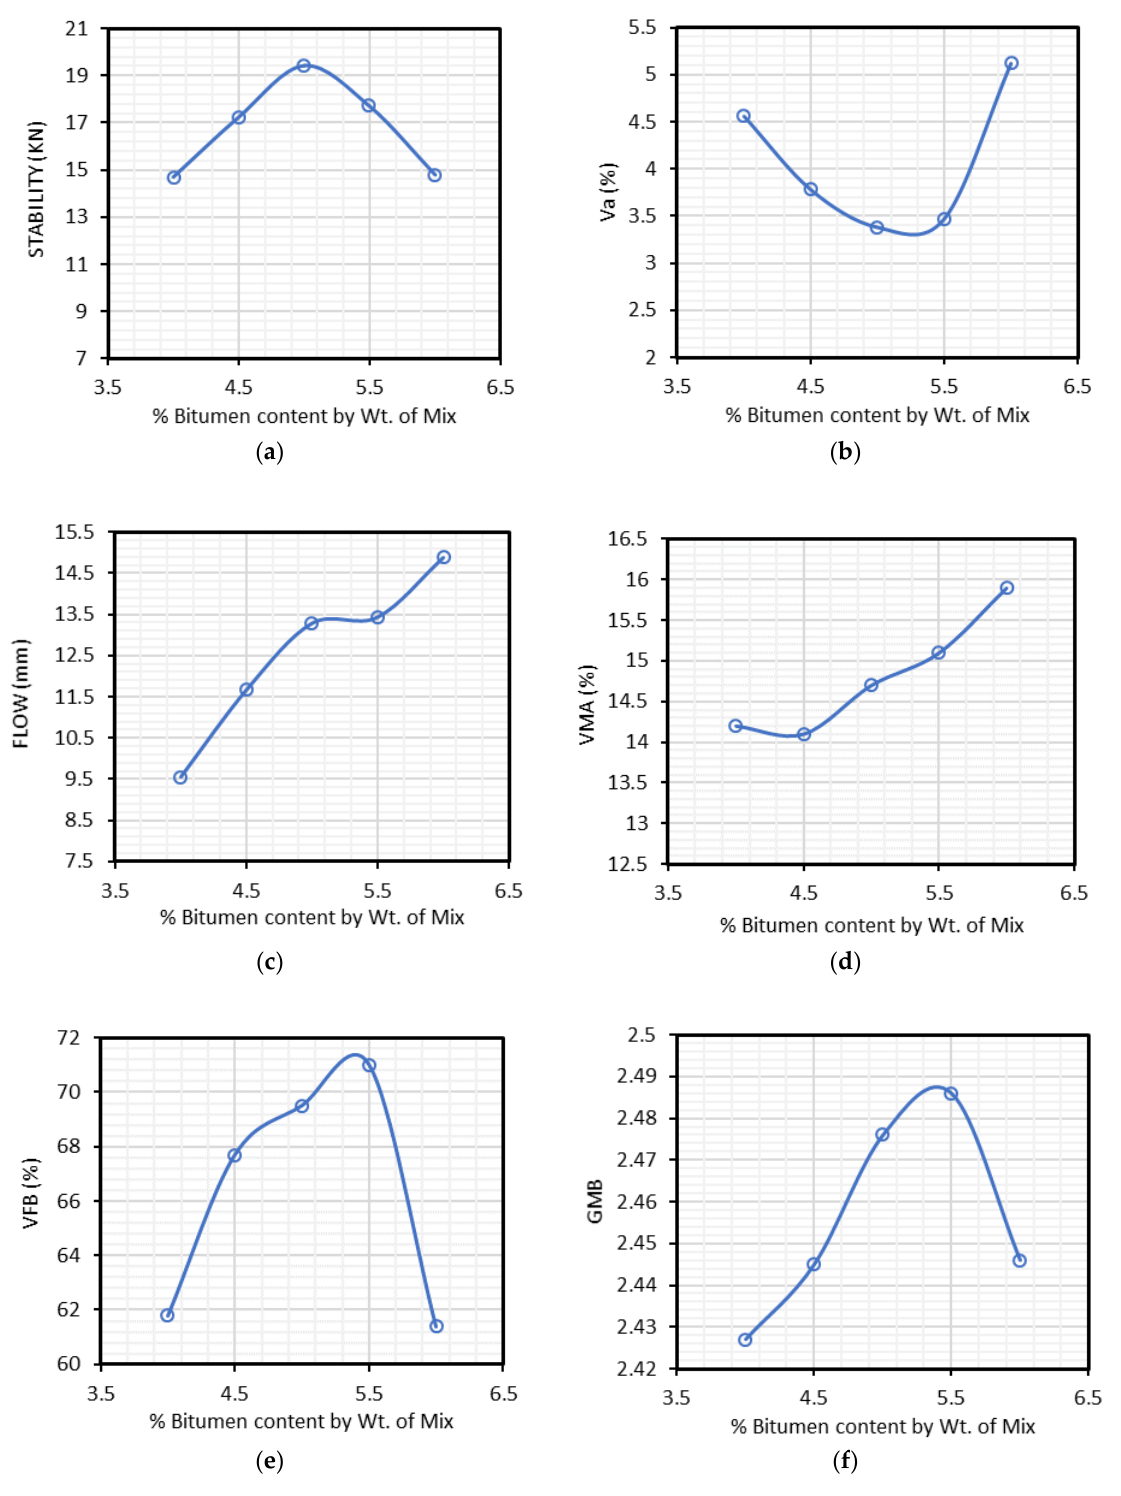
Figure 5. Effective bitumen content (EBC) calculation using the bitumen content in the mix versus